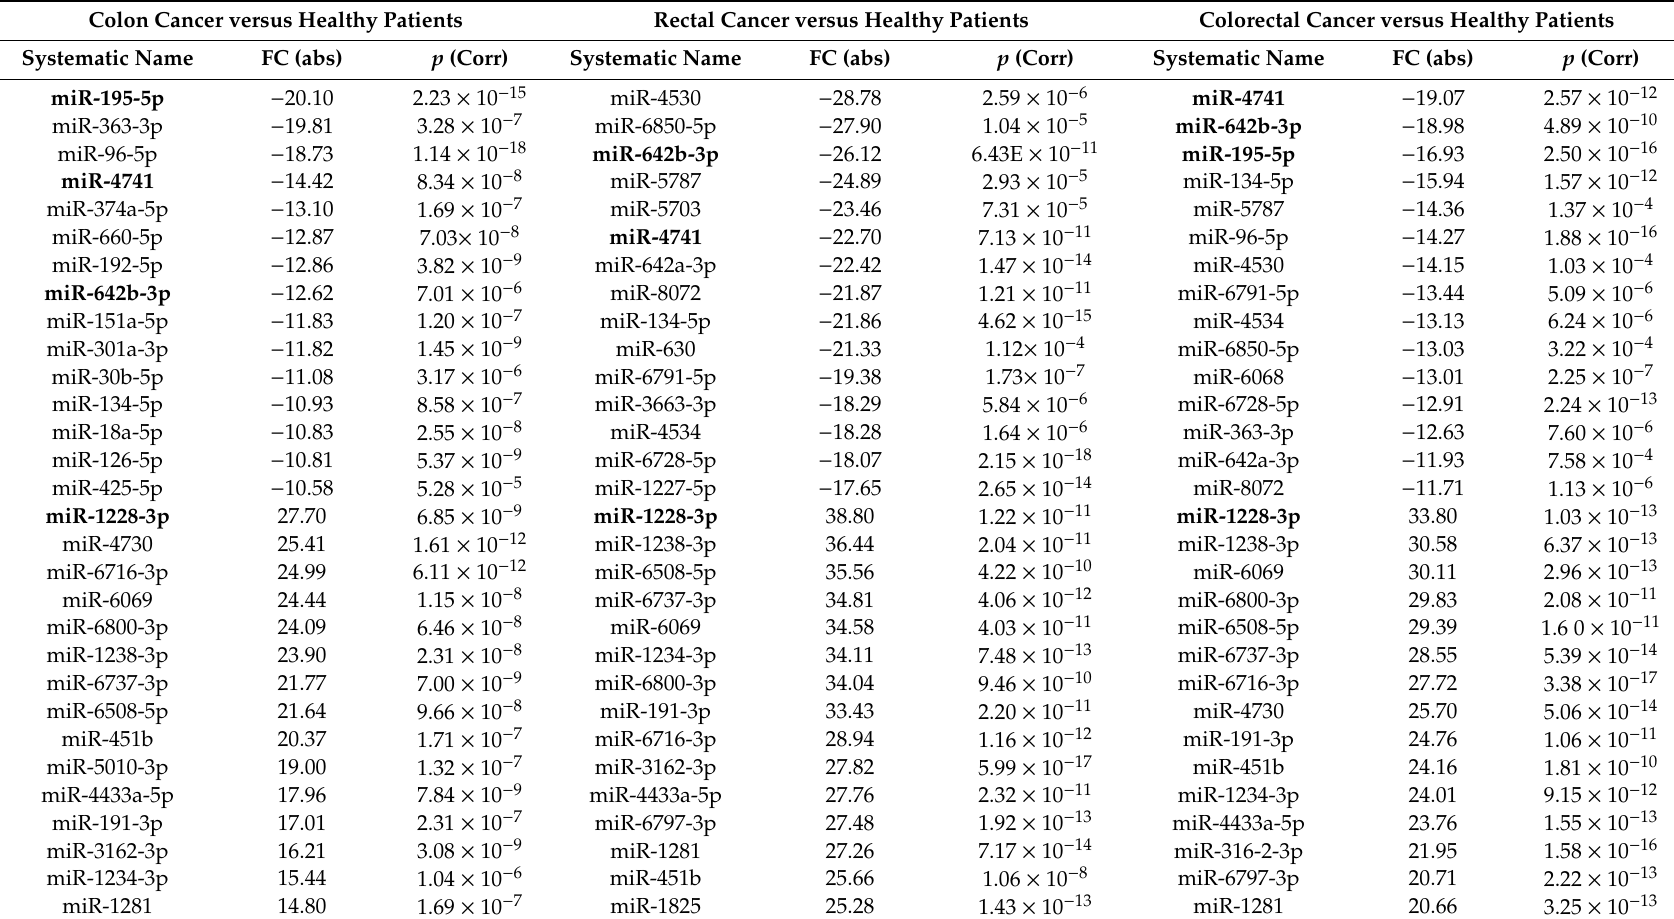
Table 4. Top 15 most upregulated and downregulated plasma microRNAs. Colon Cancer versus Healthy Patients Rectal Cancer versus Healthy Patients Colorectal Cancer versus Healthy